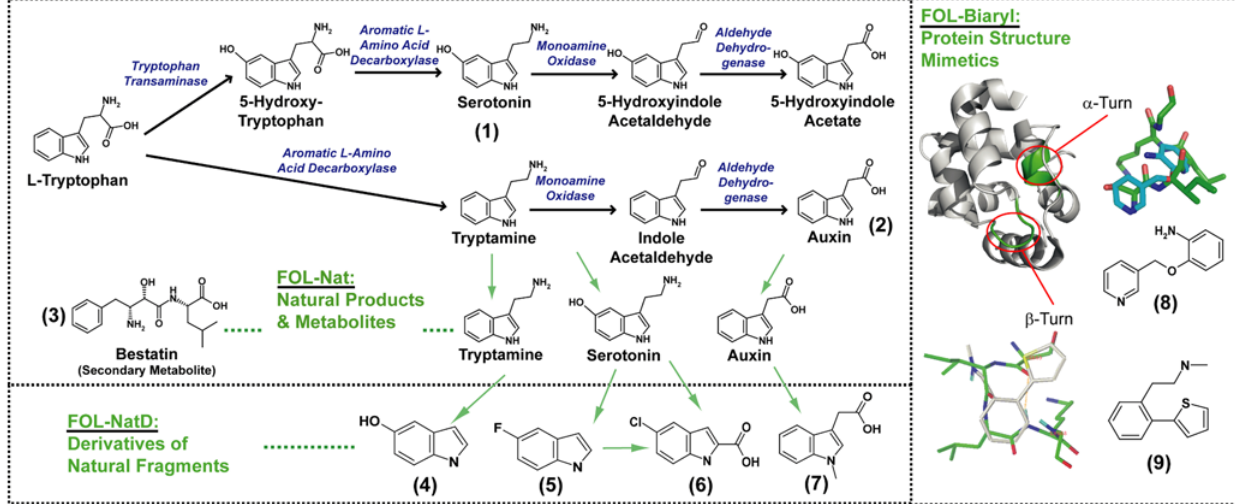
Figure 1. Conceptual organization of the deCODE biostructures Fragments of Life library. The current , 1,400-compound library contains chemically tractable natural small molecule metabolites (FOL-Nat), metabolite-like compounds and their bioisosteres (FOL-NatD), and biaryl mimetics of protein architecture (FOL-Biaryl). The FOL-Nat members include any natural molecule of molecular weight , 350 daltons that exists as a substrate, natural product, or allosteric regulator of any metabolic pathway in any cell type, such as the biosynthetic pathways for the neurotransmitter serotonin ( 1 ) and the plant hormone auxin ( 2 ). The FOL-Nat members also include secondary metabolites such as bestatin ( 3 ), a secondary metabolite of Streptomyces olivoreticuli [38]. FOL-NatD fragments are defined as heteroatom-containing derivatives, isosteres, or analogs of any FOL- Nat molecule. For example, fragments 4–7 contain the indole scaffold, which is known to be a privileged building block for drug molecules [39]. To emulate protein architecture, the FOL-Biaryl fragments were selected from a variety of biaryl compounds that are potential mimics of protein a , b , or c turns [40–42]. These include a compound ( 8 ) whose structure in an energy-minimized state can be seen to mimic the architecture on an a -turn of a protein structure (here, residues Ser65-Ile66-Leu67-Lys68 of PDB ID:1RTP) and, similarly, a compound ( 9 ) whose structure mimics the b -turn of a protein structure (residues Ala20-Ala21-Asp22-Ser23).